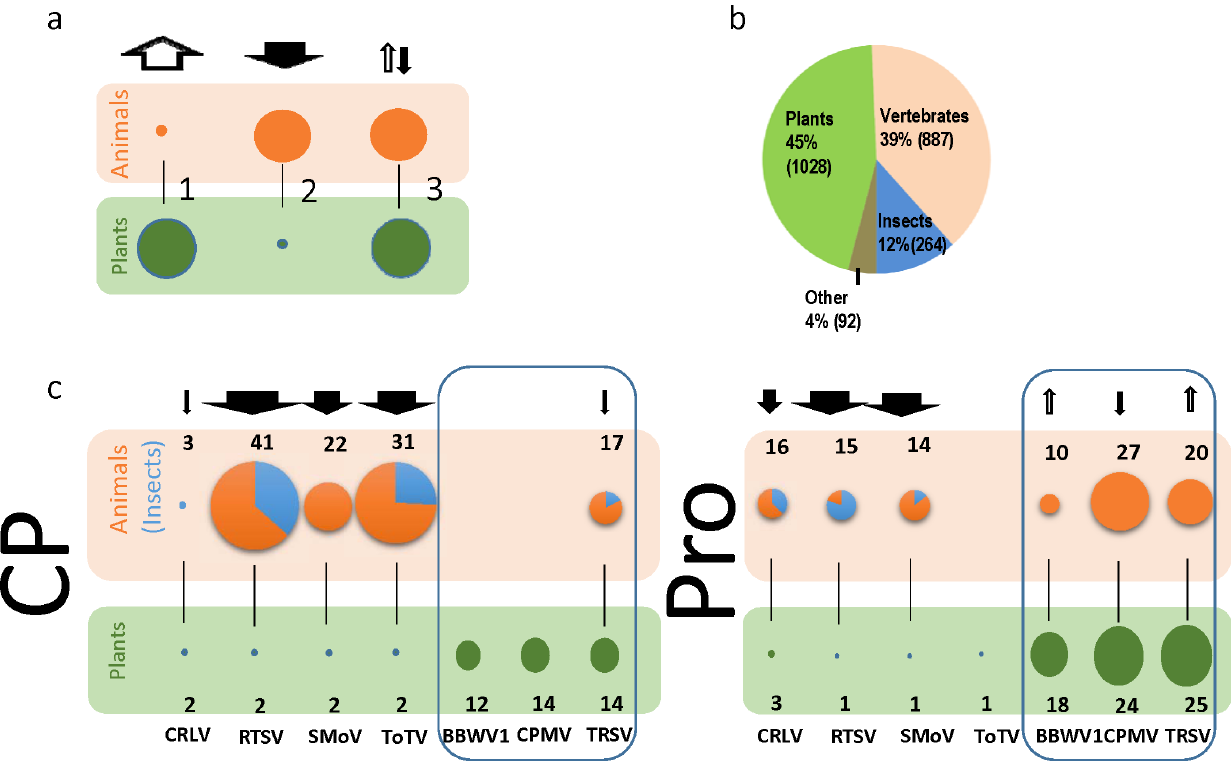
Figure 6. Host distribution of known related virus sequences. a) three putative models for assigning directionality of colonization based on diversity (proportional to the diameter of circle); the greater the diversity the older the population. In model three the distributions have reached an ‘equilibrium’ due to the limits of detection (ie the most divergent viruses cannot be identified), b) the distribution of the total number (in parentheses) of recognized ICTV classified viruses according to eukaryotic host. c) distribution, within the framework of the models proposed in a), of related ICTV-recognized virus species (black numbers) for the coat protein (CP, left) and the protease (Pro, right). Circles are proportional to number of species (orange – vertebrate host, blue – insect host). Arrow sizes are proportional to the ratio of the number of species in each host type (e.g. animal species:plant species or plant species:animal species). Absence of the thin black vertical line means that no significant animal homolog was identified. The rounded blue boxes contain members of the subfamily Comovirinae . Broad bean wilt virus-1 (BBWV1), Cherry rasp leaf virus (CRLV), Grapevine fanleaf virus (GFLV), Rice tungro spherical virus (RTSV ), Strawberry mottle virus (SMoV), Strawberry latent ringspot virus (SLRSV), Tobacco ringspot virus (TRSV), and Tomato torrado virus (ToTV).